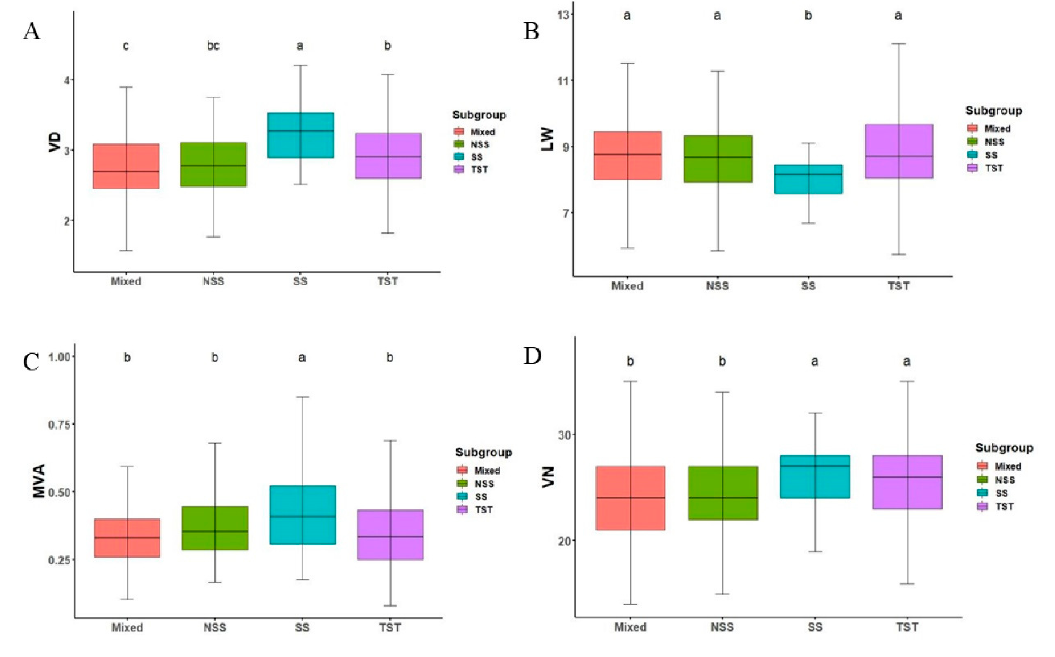
Figure 4. Analysis of differences in ear leaf veins’ phenotypic traits among different subgroups. ( A ) Vein density (VD), ( B ) leaf width (LW), ( C ) midvein area (MVA), ( D ) vein number (VN). Different lowercase letters of the same index show significant difference at 0.05 level. Table 3. Single-factor variance analysis among different subgroups of ear leaf veins’ phenotypic Table 4. Important loci in genome-wide association study of maize ear leaf veins’ phenotypic traits.